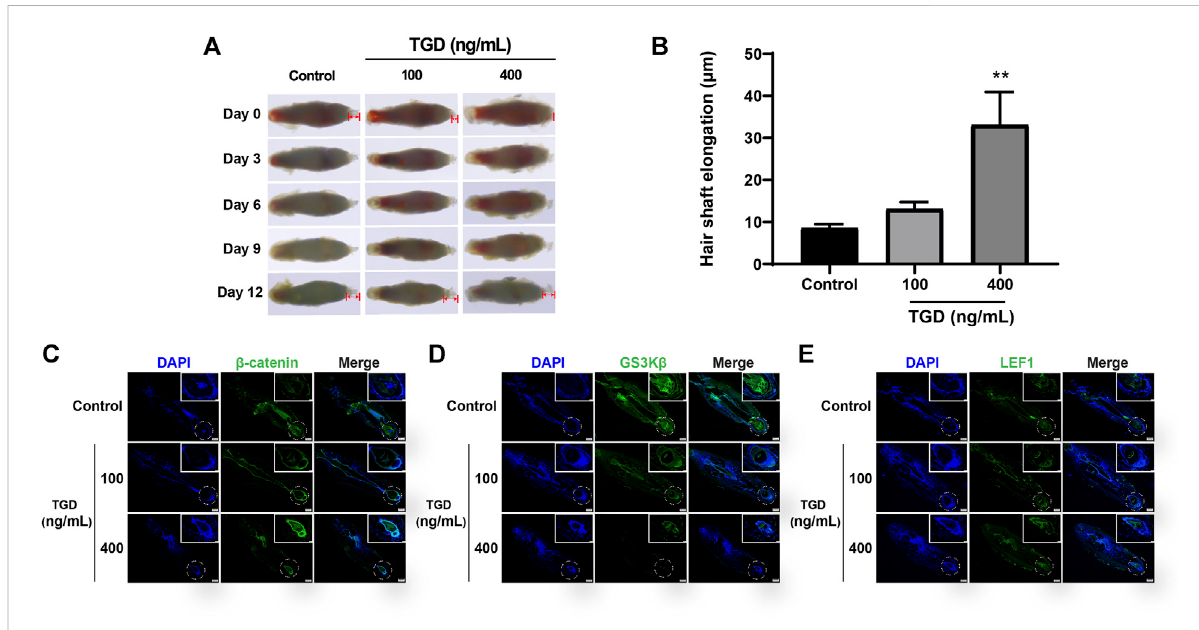
FIGURE 8 TGD promoted hair shaft elongation in rat vibrissa follicles. (A) Photographs of rat vibrissa follicles cultured with TGD for 0, 3, 6, 9, 12 days; The double arrowarea represents themeasuredhair shaftlength. (B) Changes inlength of hairshaftsinthevibrissa follicles treatedwith TGD for 12 days. Data are presented as mean ± SEM ( n = 6). ** p < 0.01 compared with the control group. (C – E) The representative images of immuno fl uorescence staining in rat vibrissa follicles for β -catenin, GSK3 β , LEF1 (×40), picture of magni fi cation ×200 in white